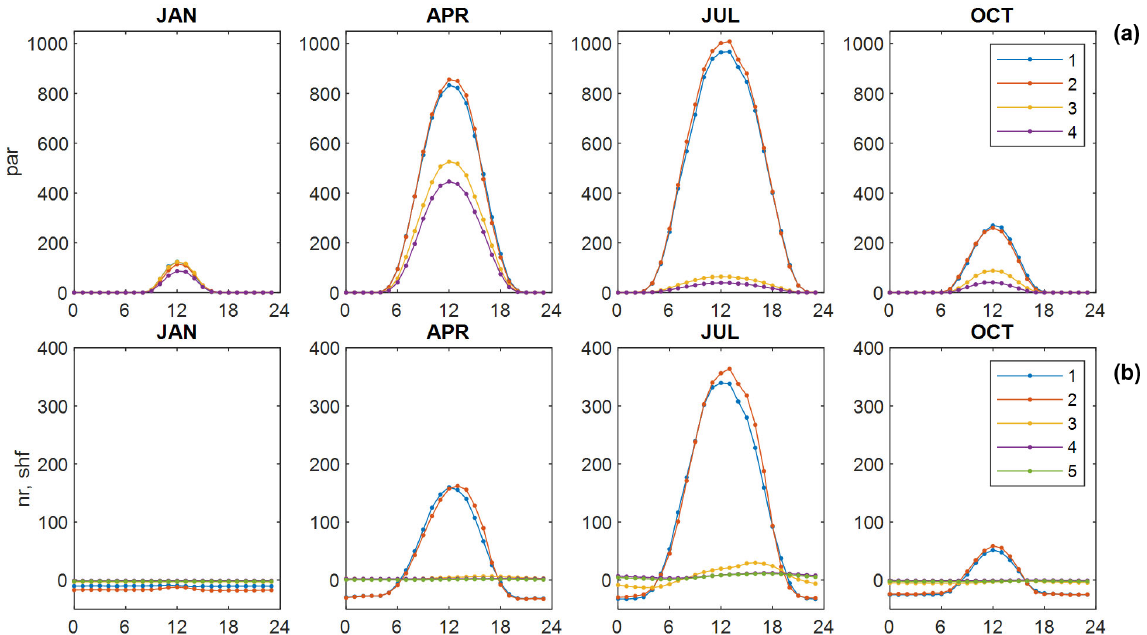
Figure 4. Monthly averaged diurnal course of incoming and reflected photosynthetically active radiation (a) (µmolm − 2 s − 1 ) and net radi- ation balance, soil heat flux (b) (Wm − 2 ) at hollow and ridge in January, April, July, and October. Mean values for 2010–2019. Legend: (a) 1: incoming PAR, hollow; 2: incoming PAR, ridge; 3: reflected PAR, hollow; 4: reflected PAR, ridge. (b) 1: net radiation, hollow; 2: net radiation, ridge; 3: soil heat flux, hollow; 4: soil heat flux, ridge, site 1; 5: soil heat flux, ridge, site